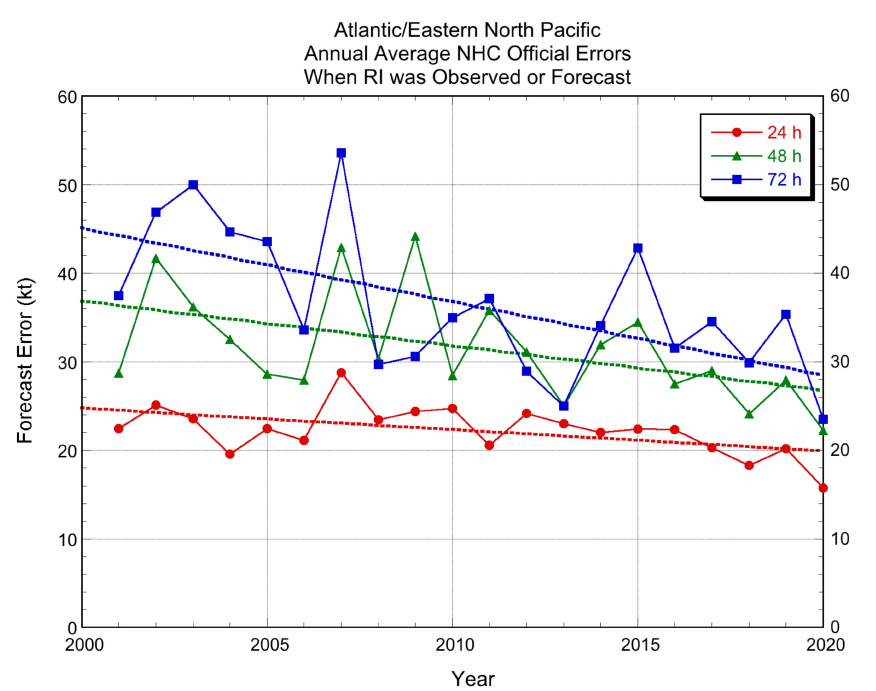
Figure 15. Historical annual average performance of the NHC official forecast at 24, 48, and 72 h for the combined Atlantic and eastern North Pacific basins for the sample of cases when RI was either observed or forecast by NHC. Least-squares trend lines are shown by dashed lines. Note that the verifications for the 2020 season are preliminary as not all of NHC’s post-storm best track analyses were complete at the time this manuscript was